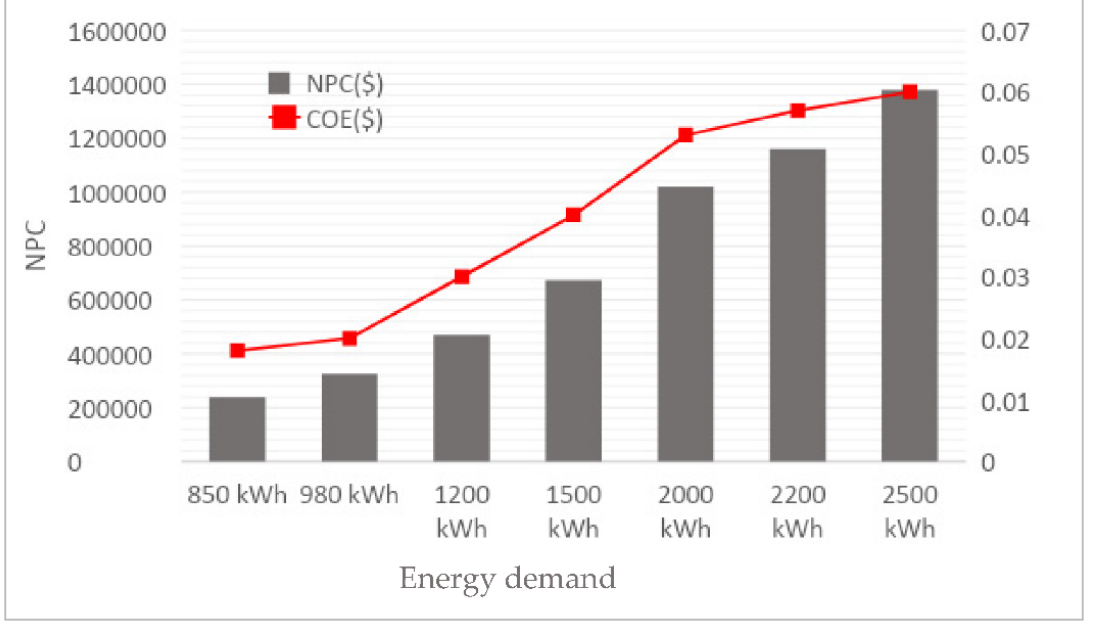
Figure 20. Effects of variability of loads on COE and NPC.